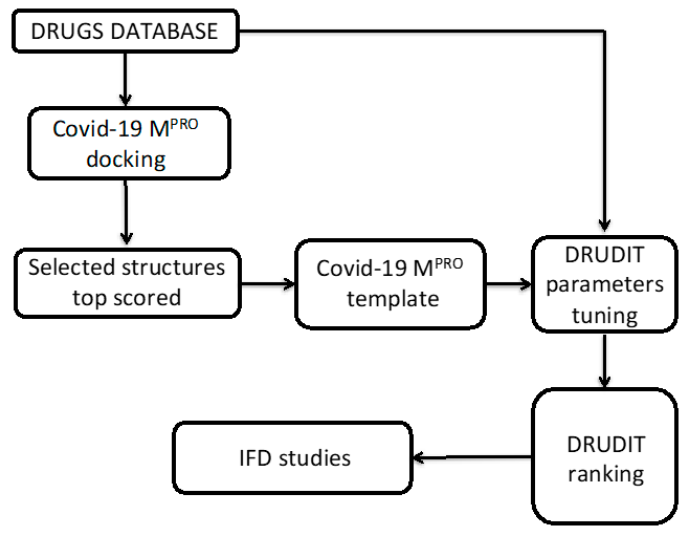
Figure 1. Flowchart of the proposed protocol. IFD, induced fit docking.